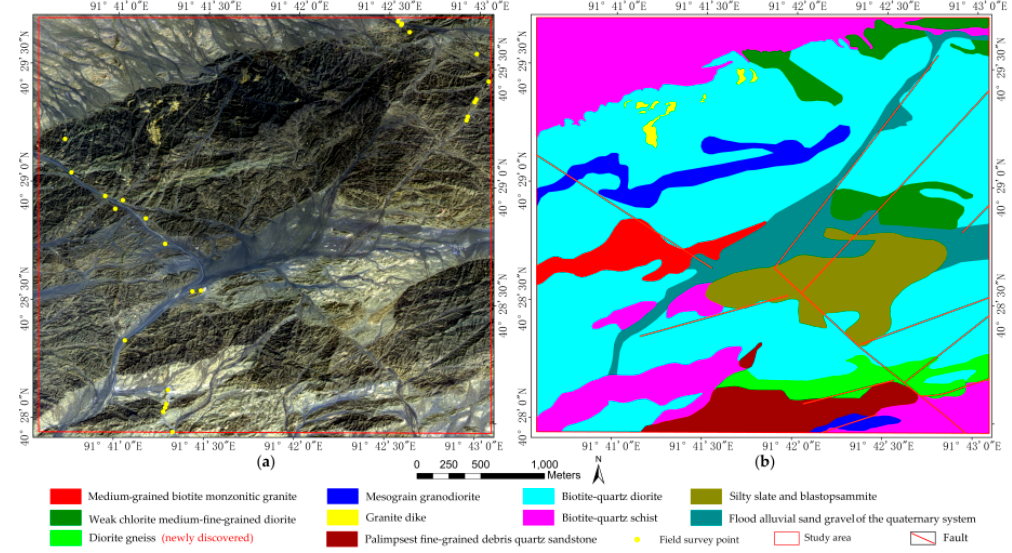
Figure 3. ( a ) Field survey points distribution map in WorldView-3 image (R: Band 8, G: Band 5, B: Band 1). These points were not evenly distributed due to the traffic restrictions, and the ground survey